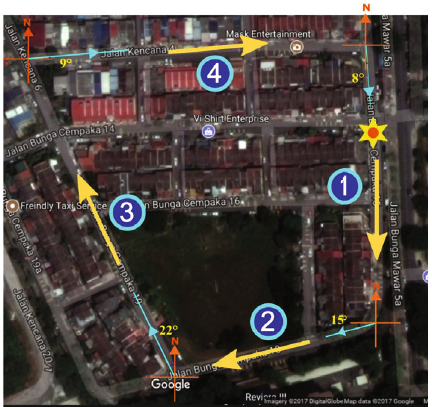
Figure 8: Raw cosine-heading angle versus fi ltering algorithms (straight path after turning — North to